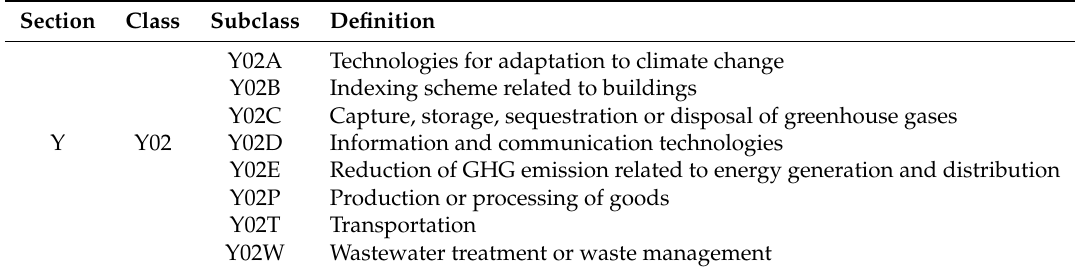
Table 1. The hierarchy of the extracted patents on climate change mitigation